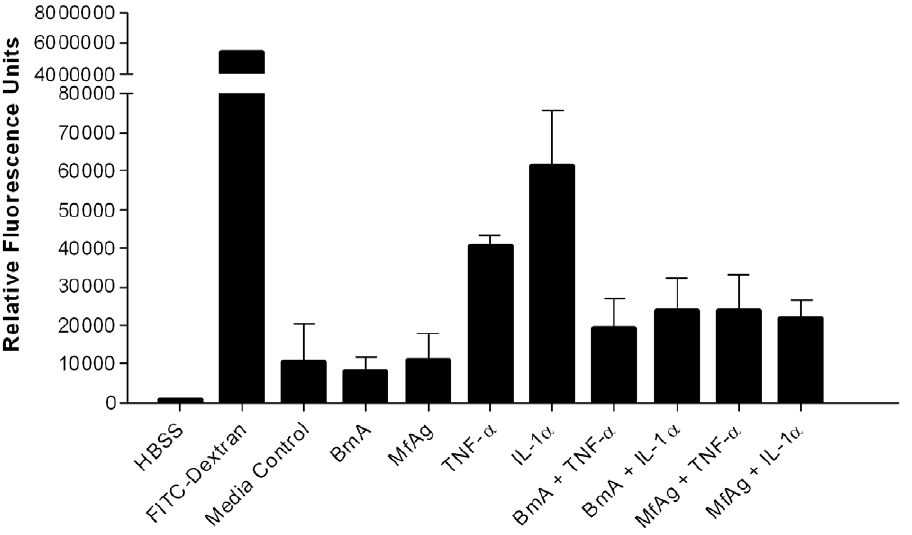
Figure 7. BmA and MfAg inhibit the TNF- a or IL-1 a induced hyper-permeability of LEC monolayers. Shown are the mean ( + 95% CI) relative fluorescence units of 4 independent permeability assays through LEC confluent monolayers.